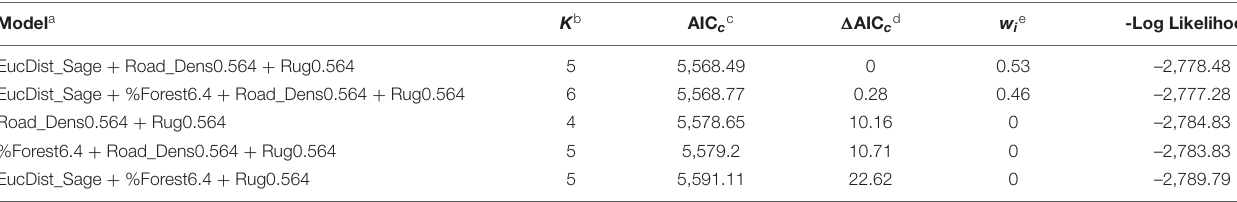
TABLE 4 | Models for winter resource selection